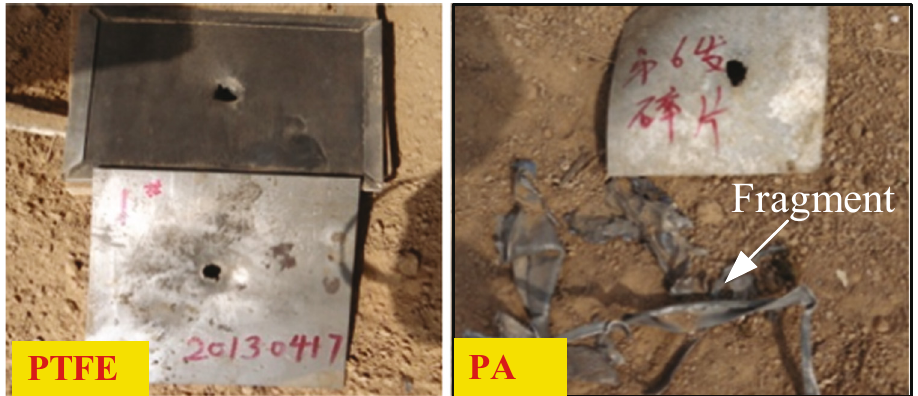
Figure 7: E ff ect of polymer expansive jet impacting